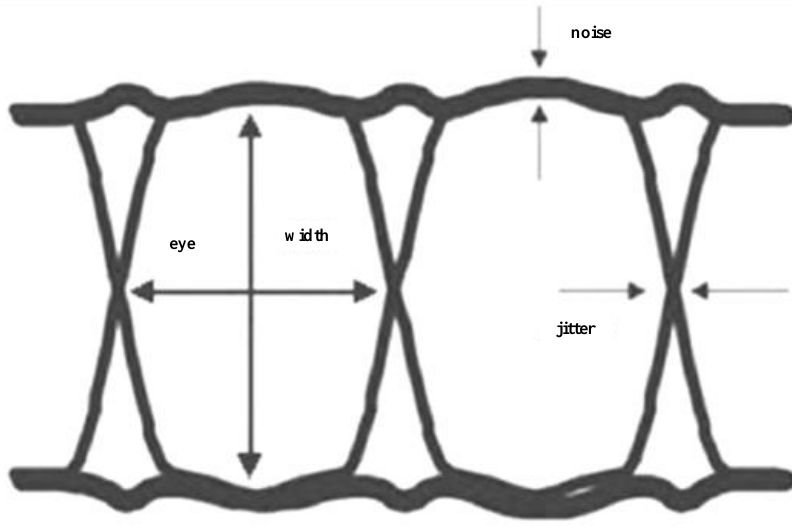
Figure 9. Eye diagram principle.